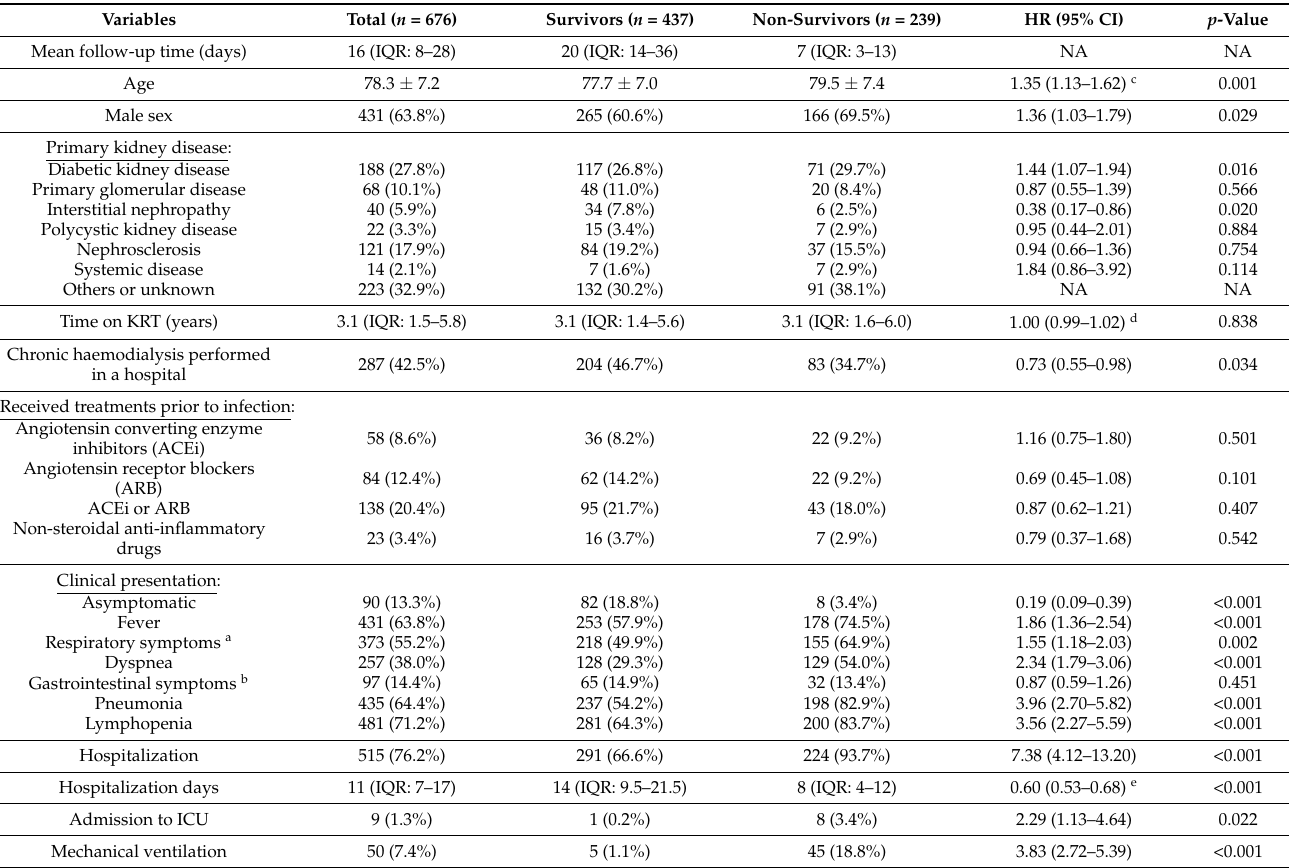
Table 3. Univariate Cox regression for mortality risk factors in elderly patients on haemodialysis with COVID-19. Values expressed in median and interquartile range (IQR), mean ± SD or n (%). HR: Hazard ratio and 95% confidence interval for the ratio. KRT: Kidney Replacement Therapy. ICU: Intensive Care Unit. NA: Not